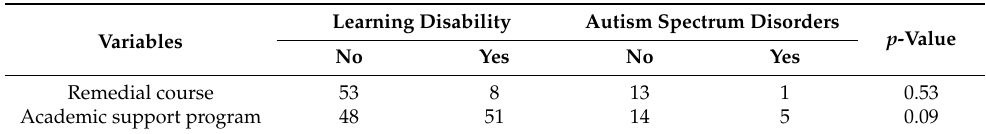
Table 3. Number of students who reported receiving remedial and academic support during their first-year in college.